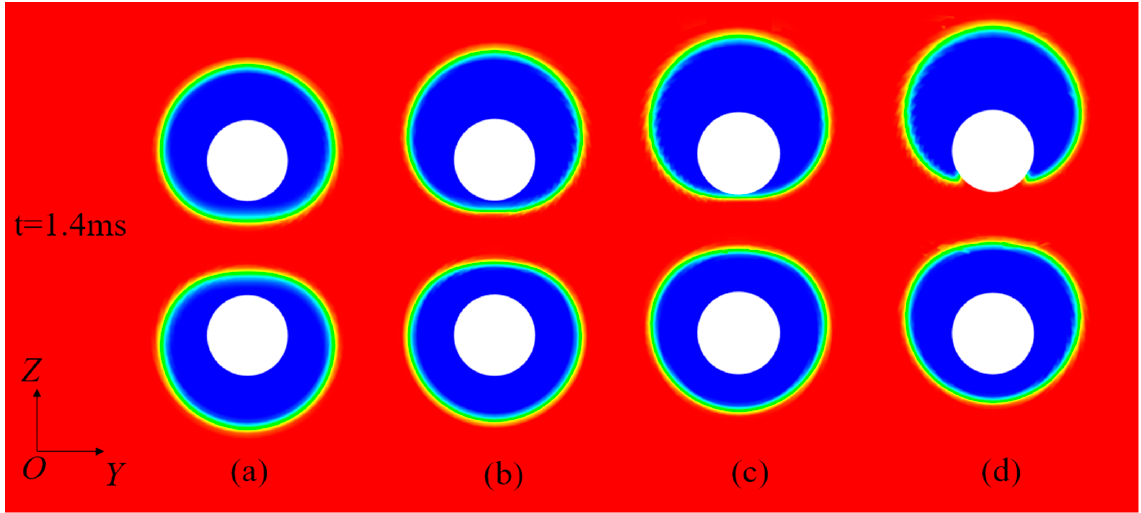
Figure 10. Cavity contour at a cross section parallel with the yoz plane (25% from the head of the projectile) under different conditions: ( a ) no lateral flow; ( b ) the lateral flow velocity V c = 3.75% V p ; ( c ) V c = 7.5% V p ; ( d ) V c = 11.25% V p .